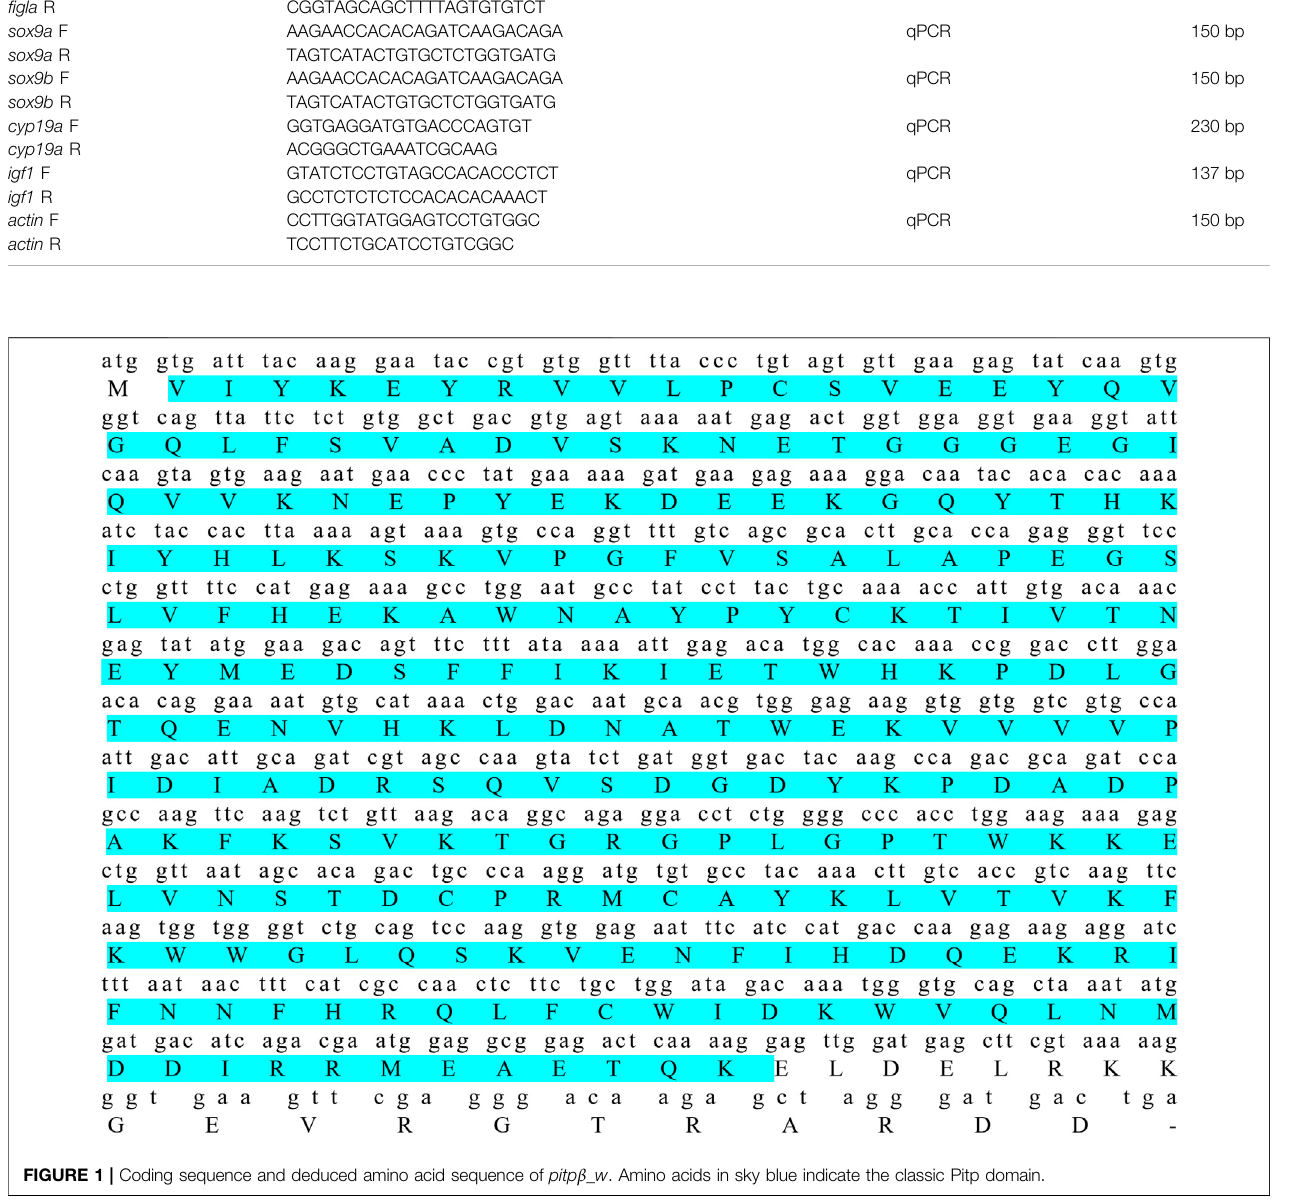
Frontiers in Genetics |